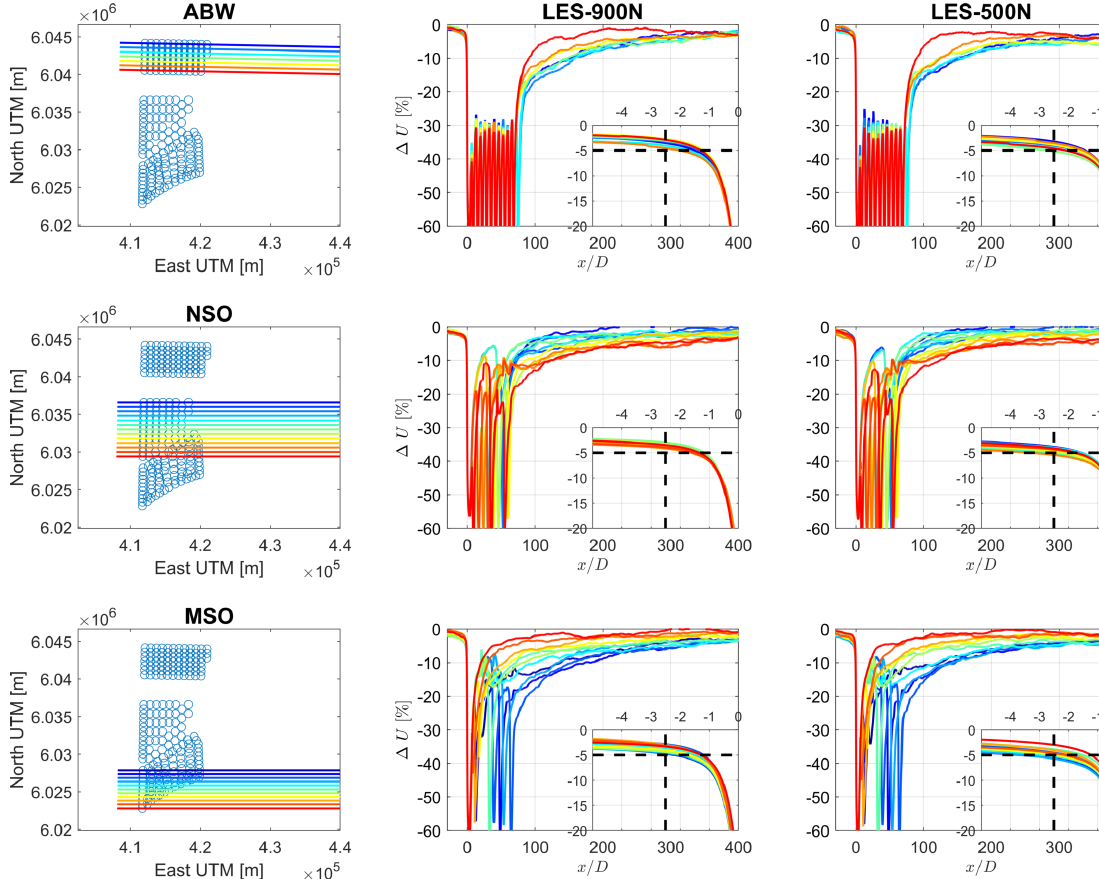
Figure 5. The percentage wind speed reduction as a function of distance from the front row turbine corresponding to the wakes and upstream (insets) of the ABW ( top ), NSO ( middle row ), and MSO ( bottom ) wind farms according to the neutral (columns 2–4) and stable (column 5) cases. The first column of panels illustrates the positions to which the curves in the other panels pertain based on the line coloring. For example, the blue curves in the top row pertain to the wind speed reduction along a line through the uppermost row of the ABW wind farm. The insets show those same lines but up to 5 D upstream of the first wind turbine. Note that the ABW curves are tilted slightly downwards (to the south) to capture the center of the turbine